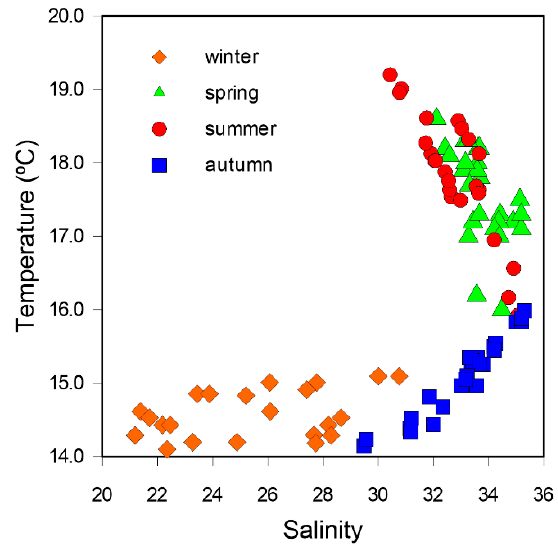
Figure 2. Temperature–salinity diagram for the surface waters sampled at the fixed station in 2007.